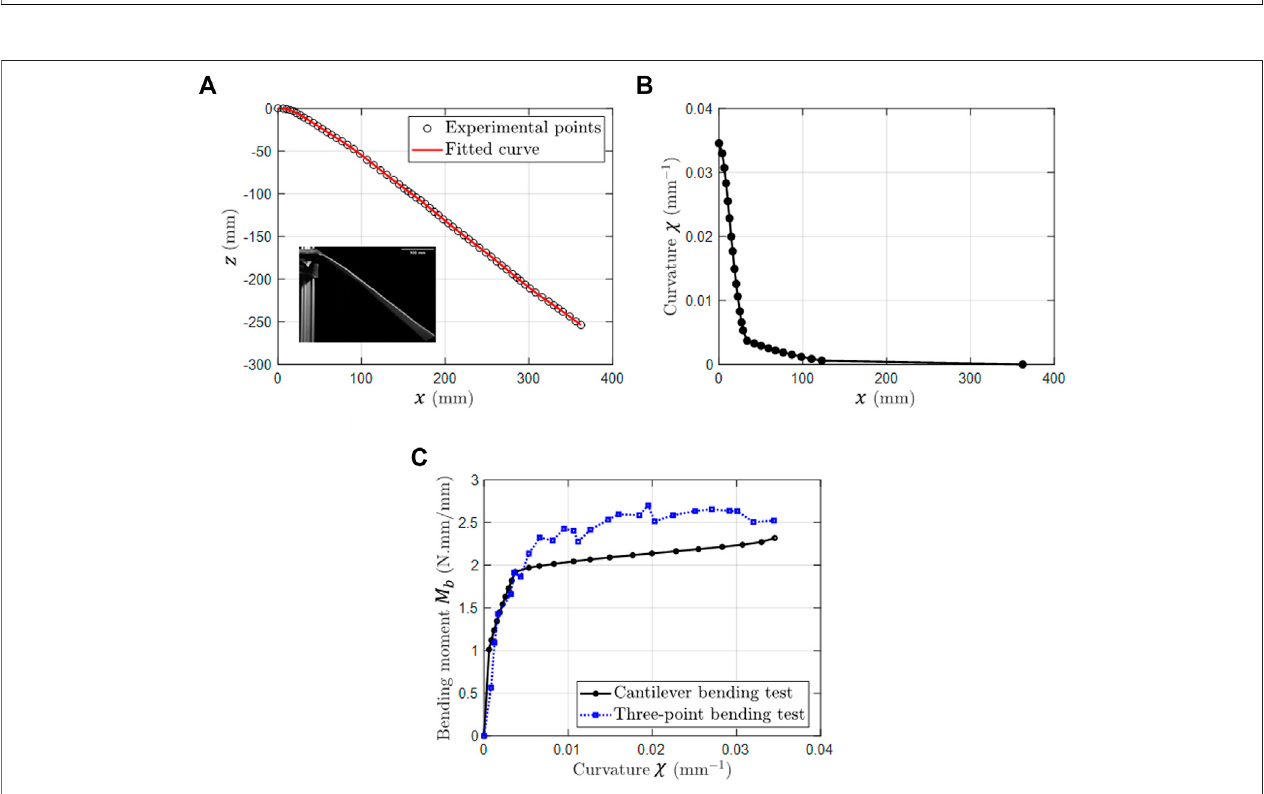
FIGURE 5 | Cantilever bending test (A) experimental points and fi tted curve of the mid-line of the deformed reinforcement, (B) curvature as a function of x , (C) bending moment as a function of curvature.